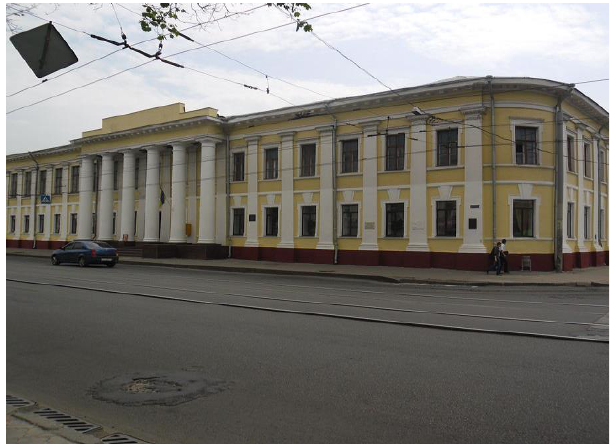
Figure 4. The former building of the First Gymnasium in Kharkiv.